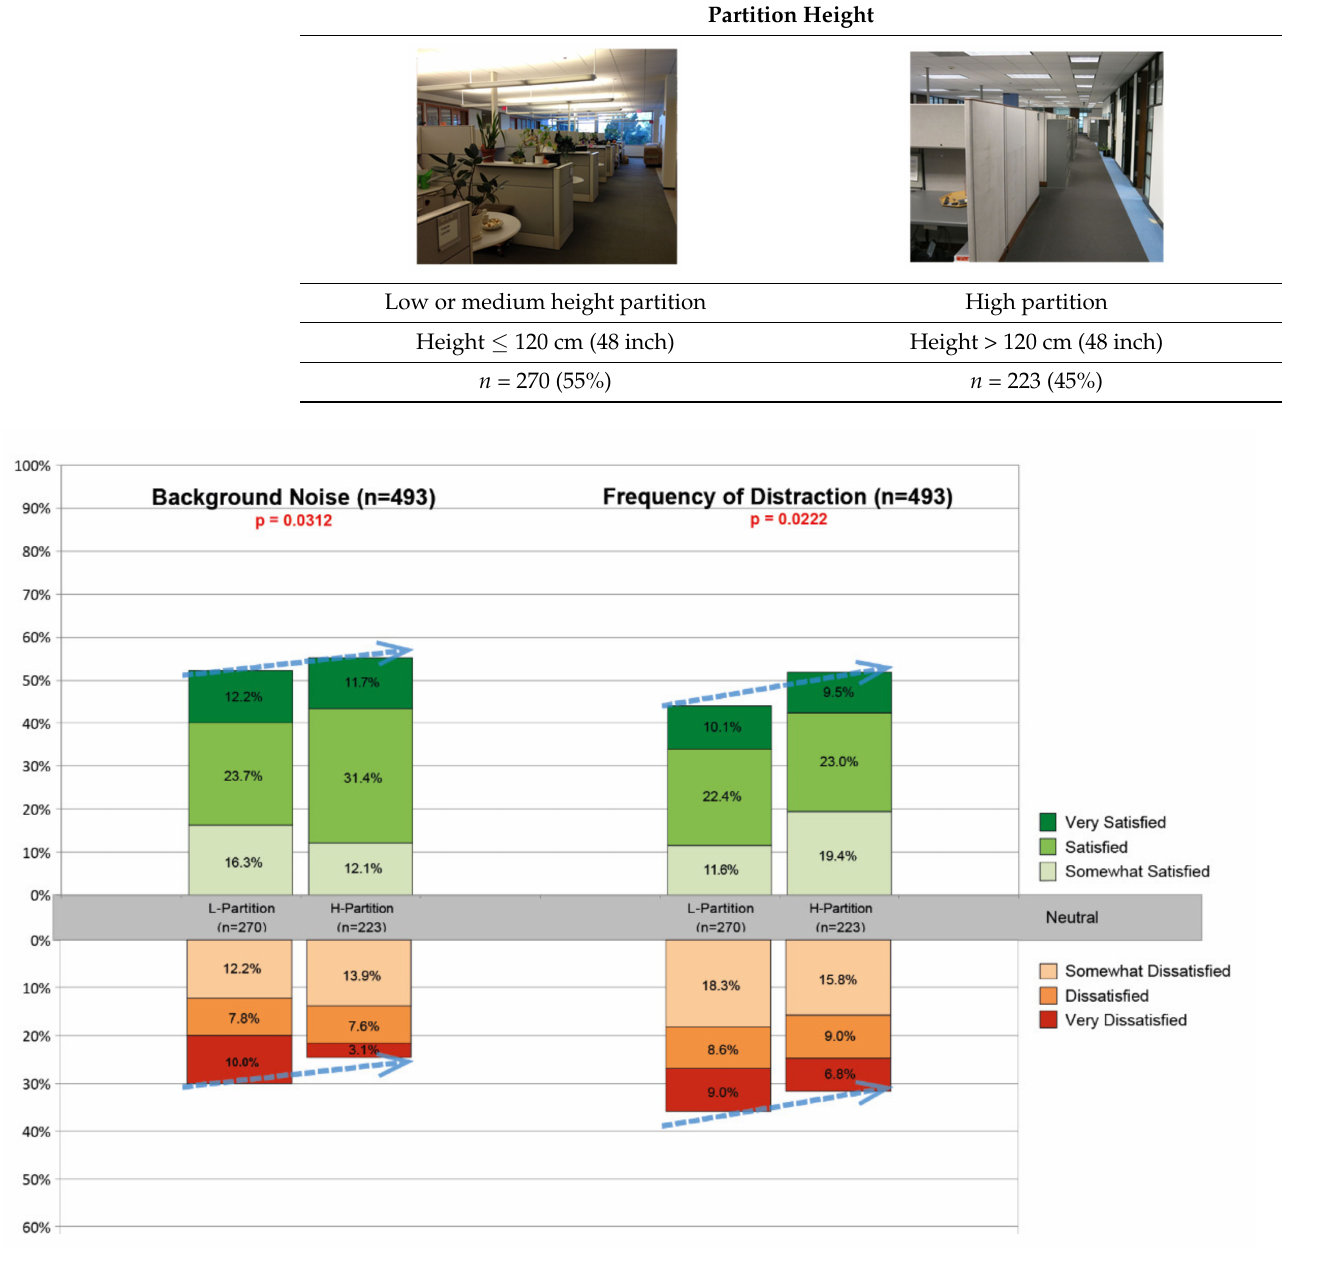
Figure 6. Acoustic satisfaction by partition height: Background noise and frequency of